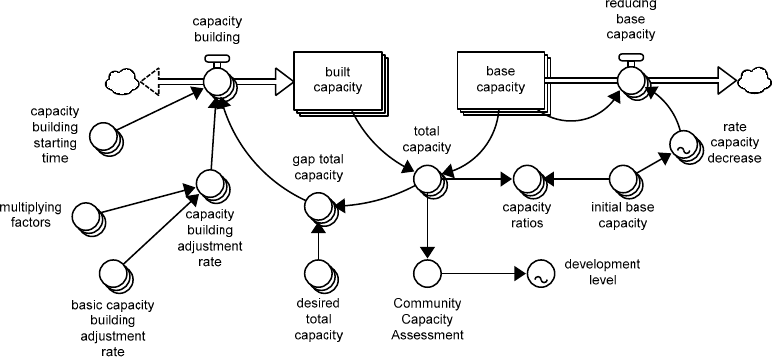
Figure 12. Stock-and-flow system dynamics representation of the dynamic of Figure 11.